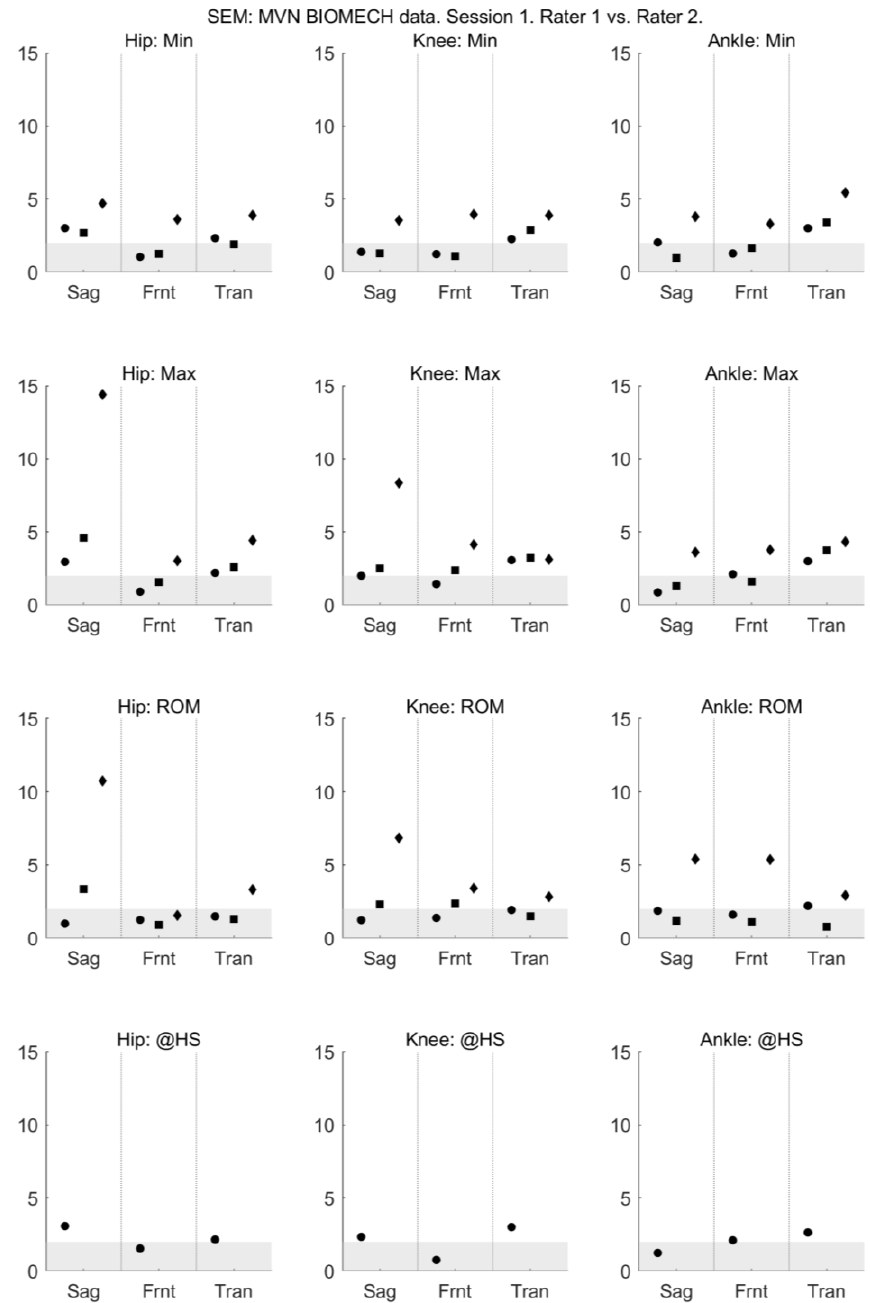
Figure 4. Between-rater standard error of measurement of MVN data collected by rater 1 (musculoskeletal physiotherapist) and rater 2 (clinical movement scientist) in session 1. Standard error of measurement is shown for the minimum angle (min; top row ), maximum angle (max; second row ), range of motion (ROM; third row ) and angle at heel strike (@HS; bottom row ) for the hip (left-most column), knee (centre column) and ankle (right-most column) joints in the sagittal (Sag), frontal (Frnt) and transverse (Tran) planes of movement. The three data points in each plane correspond to the walk (left-most point; circle), squat (centre point; square) and jump (right-most point; diamond) tasks. Grey shading indicates values considered to indicate excellent reliability.